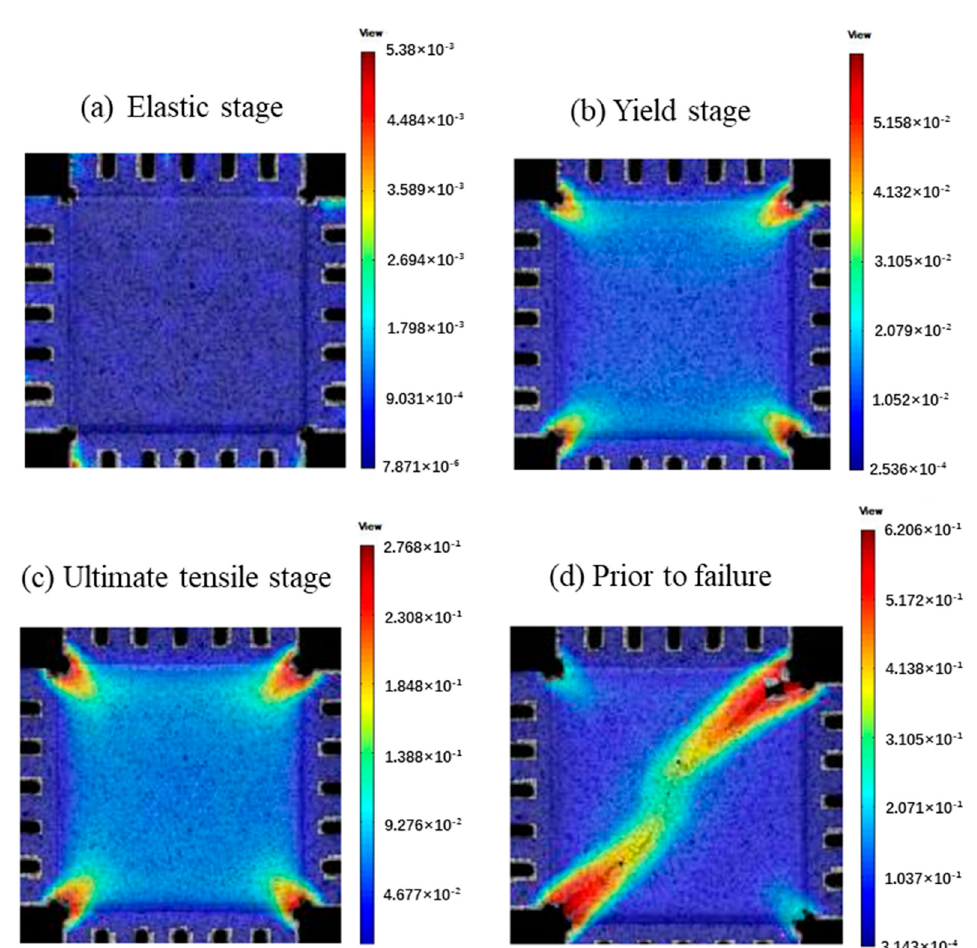
Figure 6. Strain contour plots of equi-biaxial tensile sample at various load steps: ( a ) initial stage, ( b ) yield stage, ( c ) ultimate tensile stage, ( d ) prior to failure.